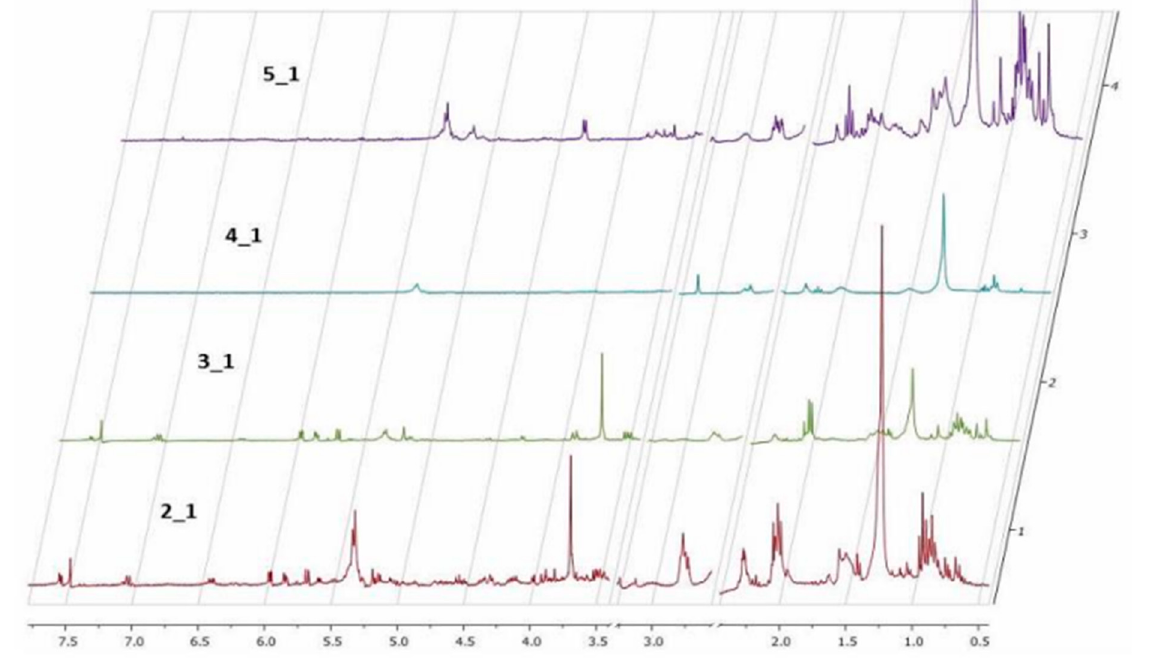
Figure 1. 1 H NMR of organic extracts in DMSO-d 6 . (2_1) Healthy Allamanda leaves; (3_1) predated Allamanda leaves; (4_1) caterpillar bodies and (5_1) caterpillar feces.